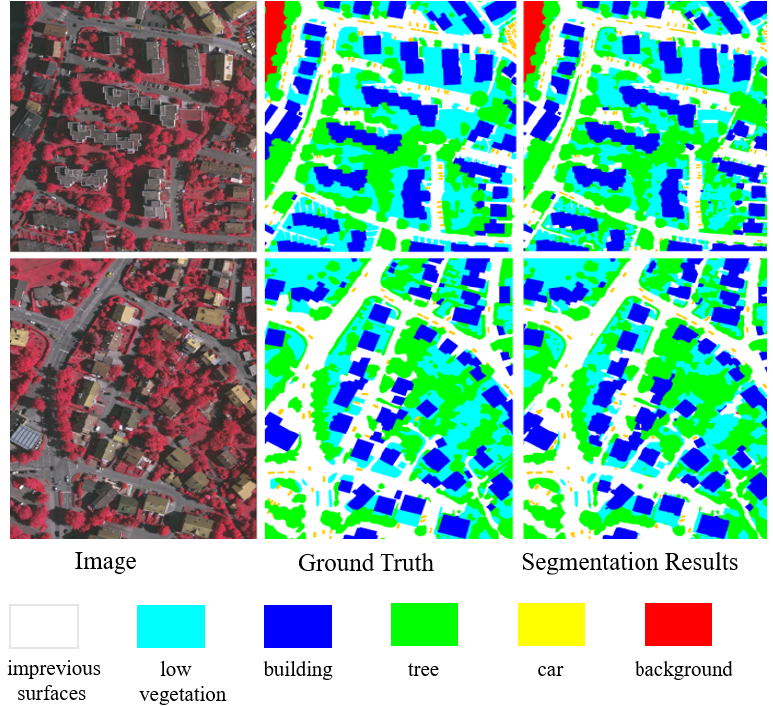
Figure 11. The segmentation results of the MCAFNet on the Vaihingen dataset.